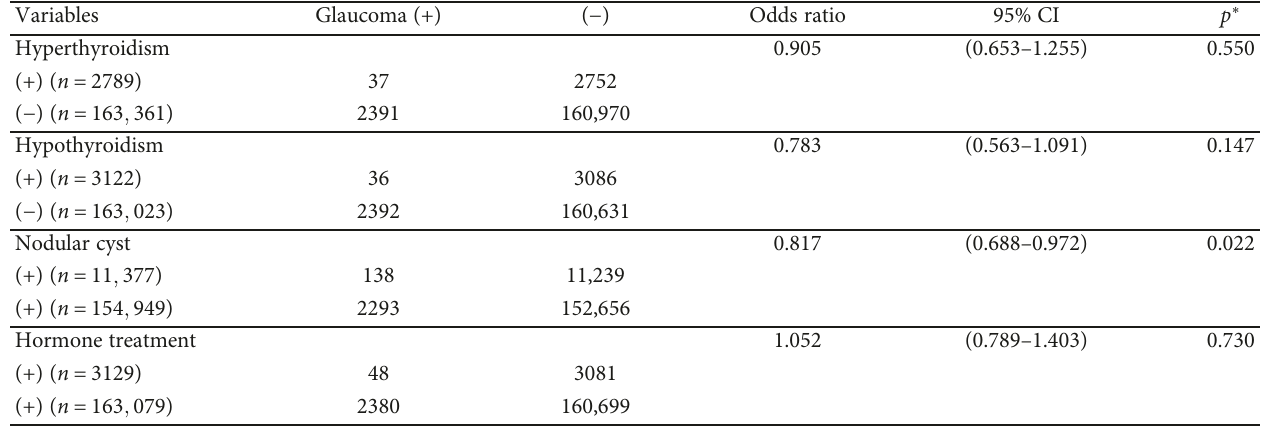
Table 7: The odds ratio between thyroid factors and